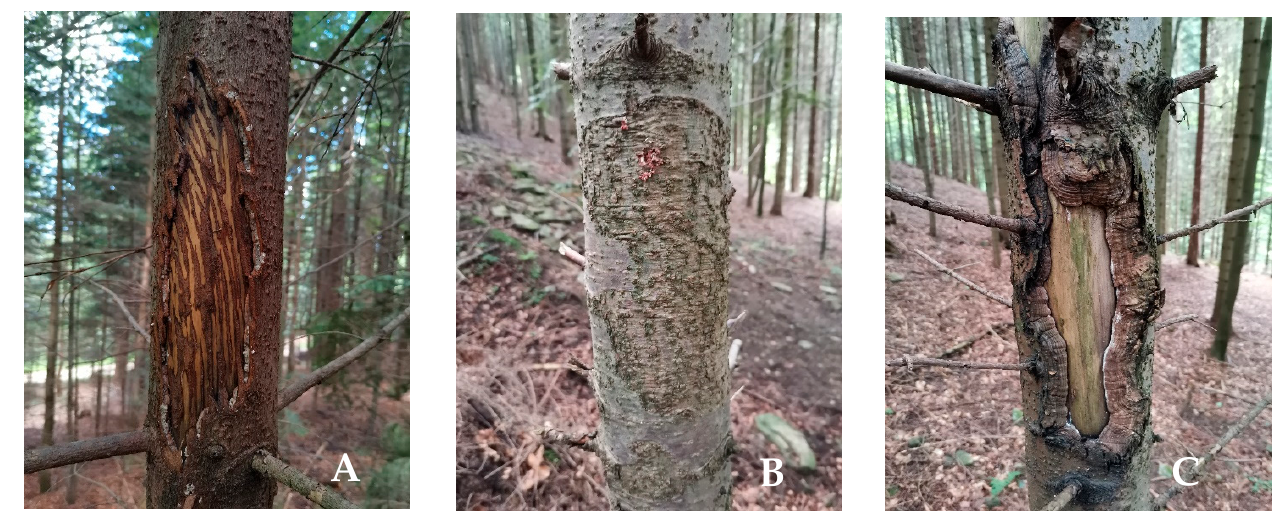
Figure 2. ( A – C ) Types of studied fir wounds caused by red deer ( Cervus elaphus ): ( A )—fresh wound “F”, ( B )—healed wound “H”, ( C )—old wound “O”.